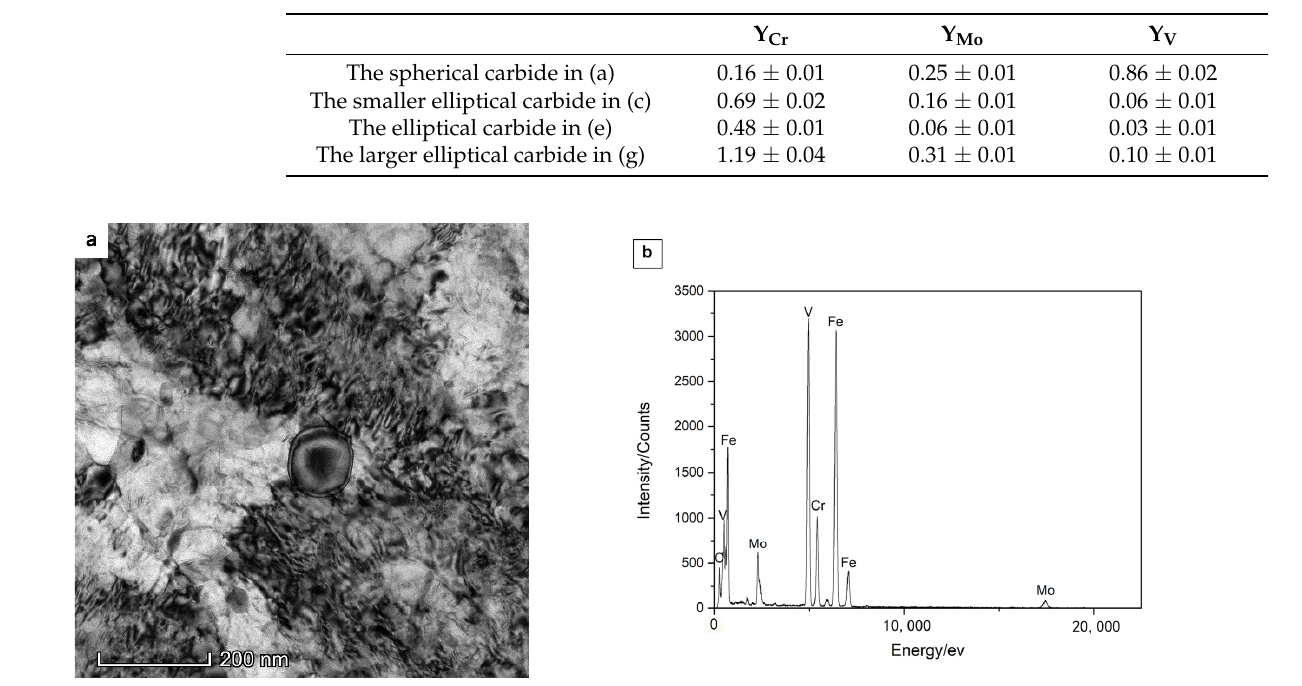
Table 4. The M to Fe ratio Y M (M = Cr, Mo, and V) for the different carbides in Figure 7 from the EDS measurements on tempering at 600 ◦ C.